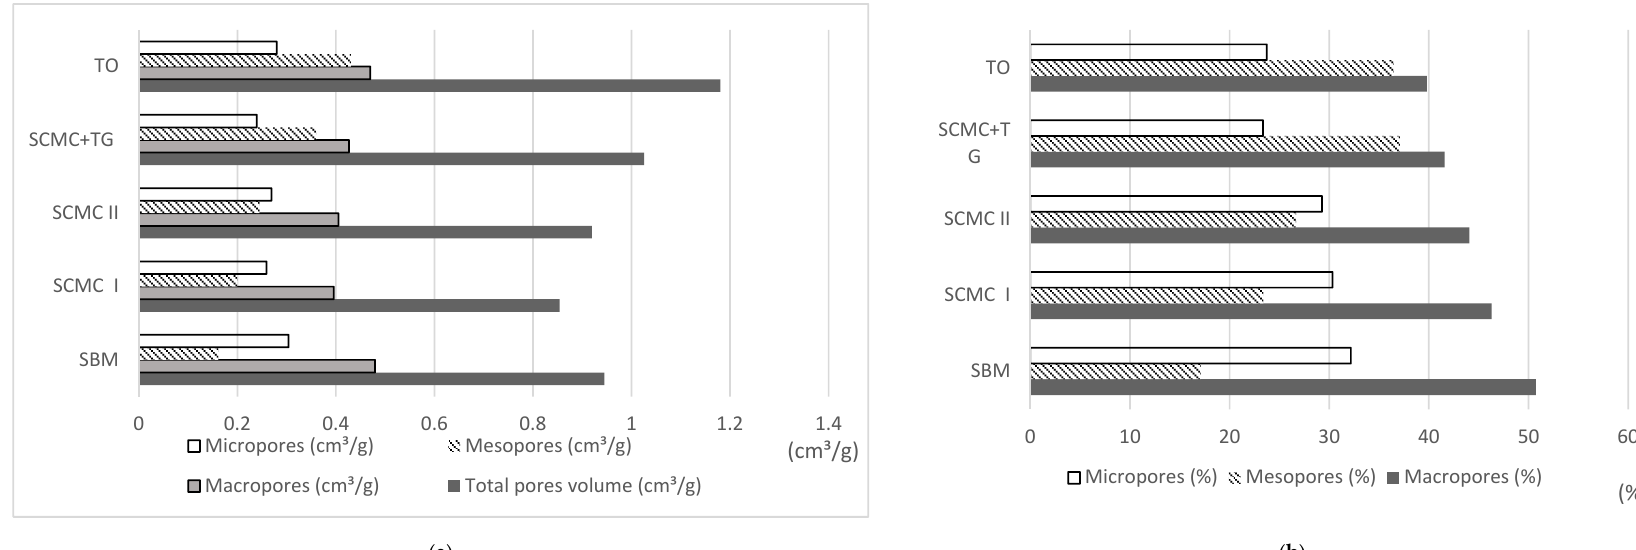
Figure 4. Structural properties of average granulated activated carbon (GAC) samples manufactured using the tested binders. Source: own elaboration, ( a ) micro-, meso- and macropores and total pores volume per 1 gram of AC ( b ) micro-, meso- and macropores ratio in AC sample in (%).